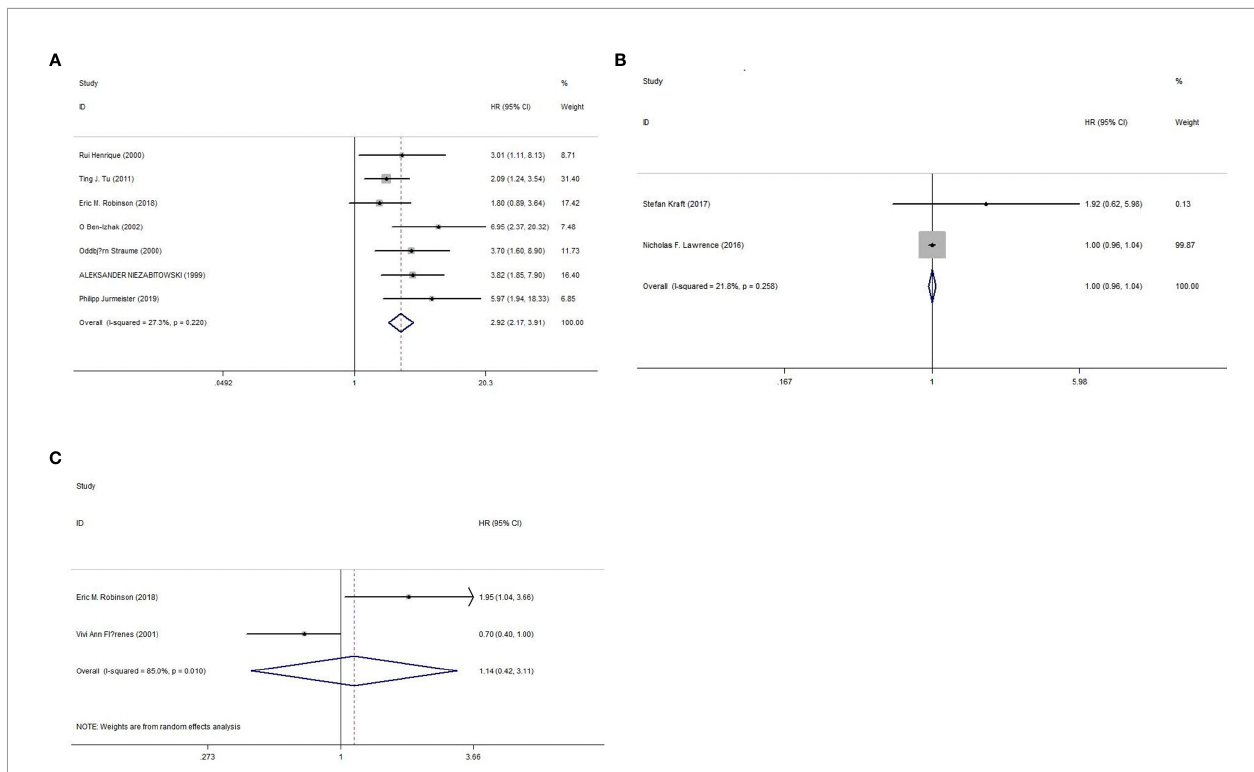
FIGURE 2 | Forest plot of OS, PFS, and RFS. (A) Meta-analysis of Ki-67 expression and OS. (B) Meta-analysis of Ki-67 expression and PFS. (C) Meta-analysis of Ki-67 expression and